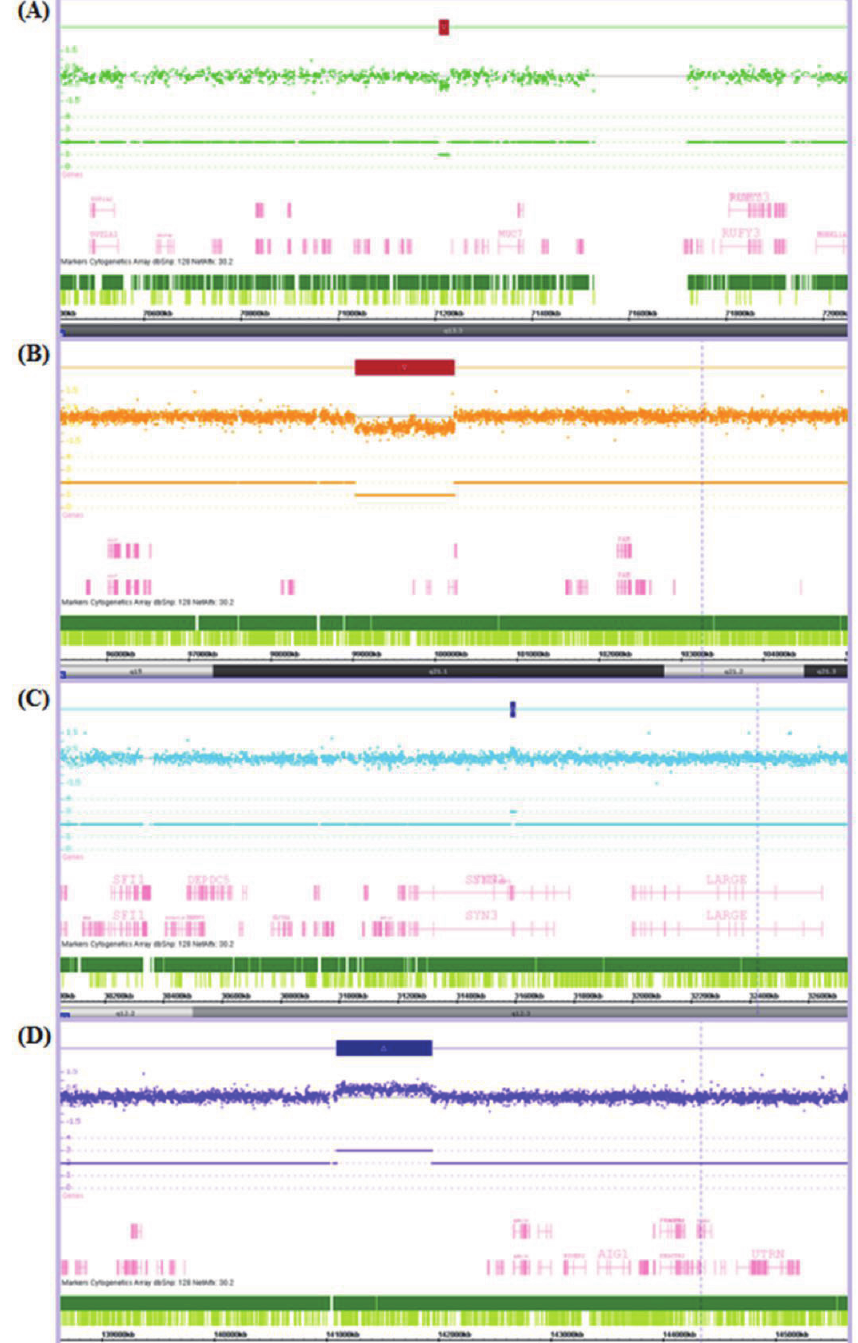
Figure 1. Chromosome Analysis Suite (ChAS) output showing examples of ( A ) a small copy number (CN) loss of 17.8 Kb; ( B ) a large CN loss of 1,205.7 Kb; ( C ) a small CN gain of 14.8 Kb; and ( D ) a large CN gain of 843.3 Kb. The Log2Ratio represents the relative fluorescence of each probe (dot) across the genome (from left to right). The fluorescence is reduced in regions of CN loss and increased in regions of CN gain. This is indicated by a CN loss (red box) or CN gain (blue box) over the affected region and the resultant CN state noted below e.g., there is only one of the two alleles present in each CN loss and an extra allele present in each of the CN